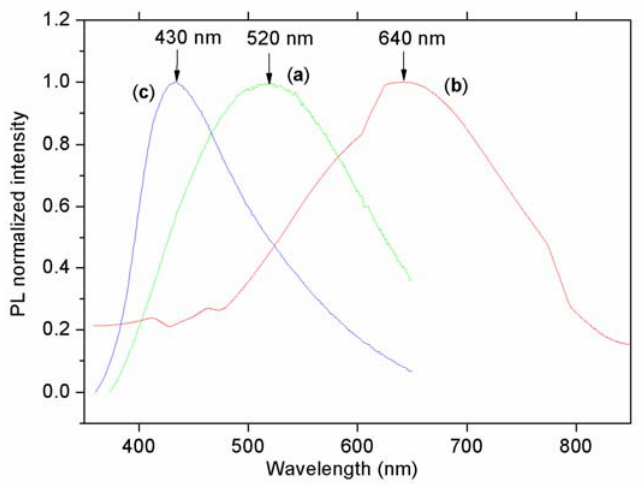
Figure 9. Steady state PL spectra of OBMPA in solution (a) and (b) thin films and OMPA in solution (c) ; (excitation wavelength 350